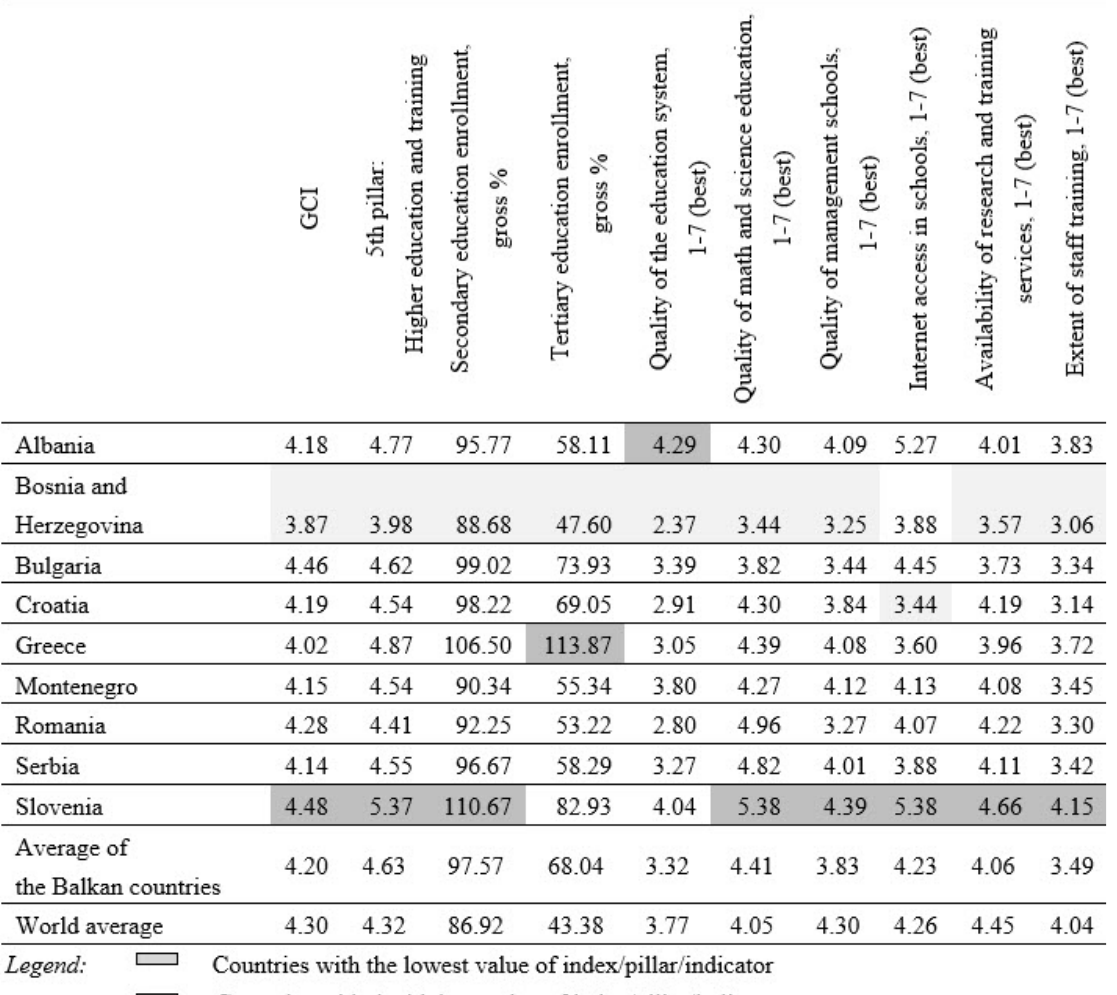
of the observed index, pillar and indicators for the Balkan countries and for total of 137 world countries whose results are measured by the WEF in its last Table 1. Score of the GCI, “Higher education and training” pillar and indicators within the “Higher education and training” pillar (2017)